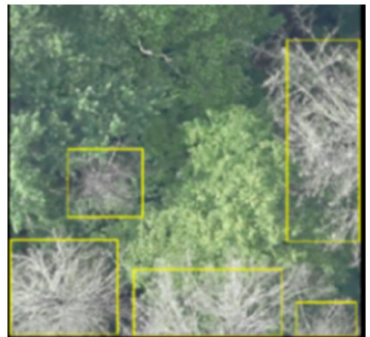
Figure 2. Sample annotation schematic of the target detection model dataset.